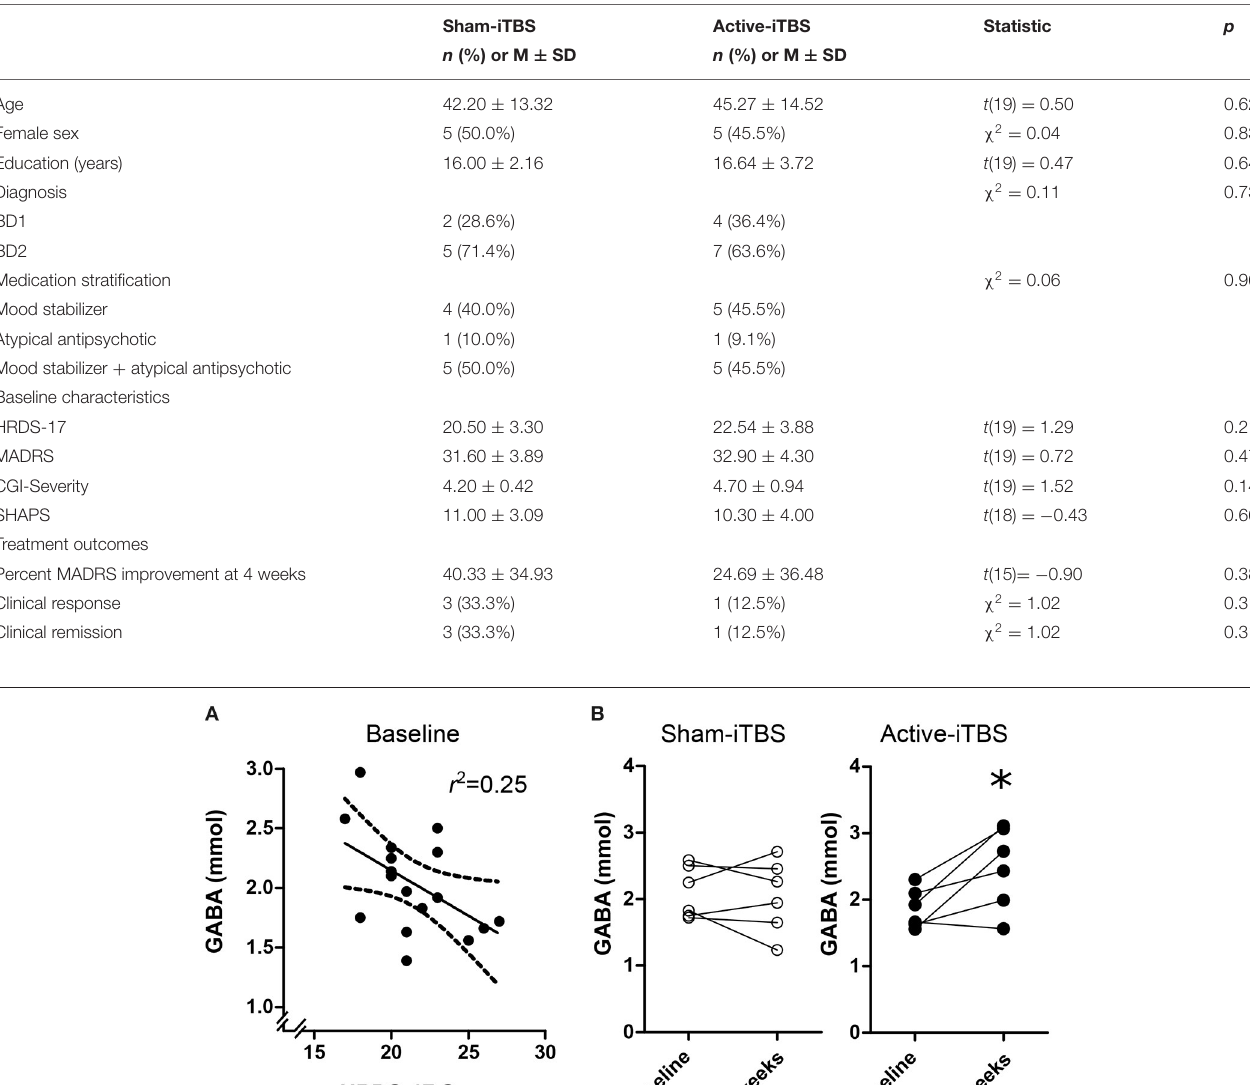
TABLE 1 | Sample characteristics and clinical